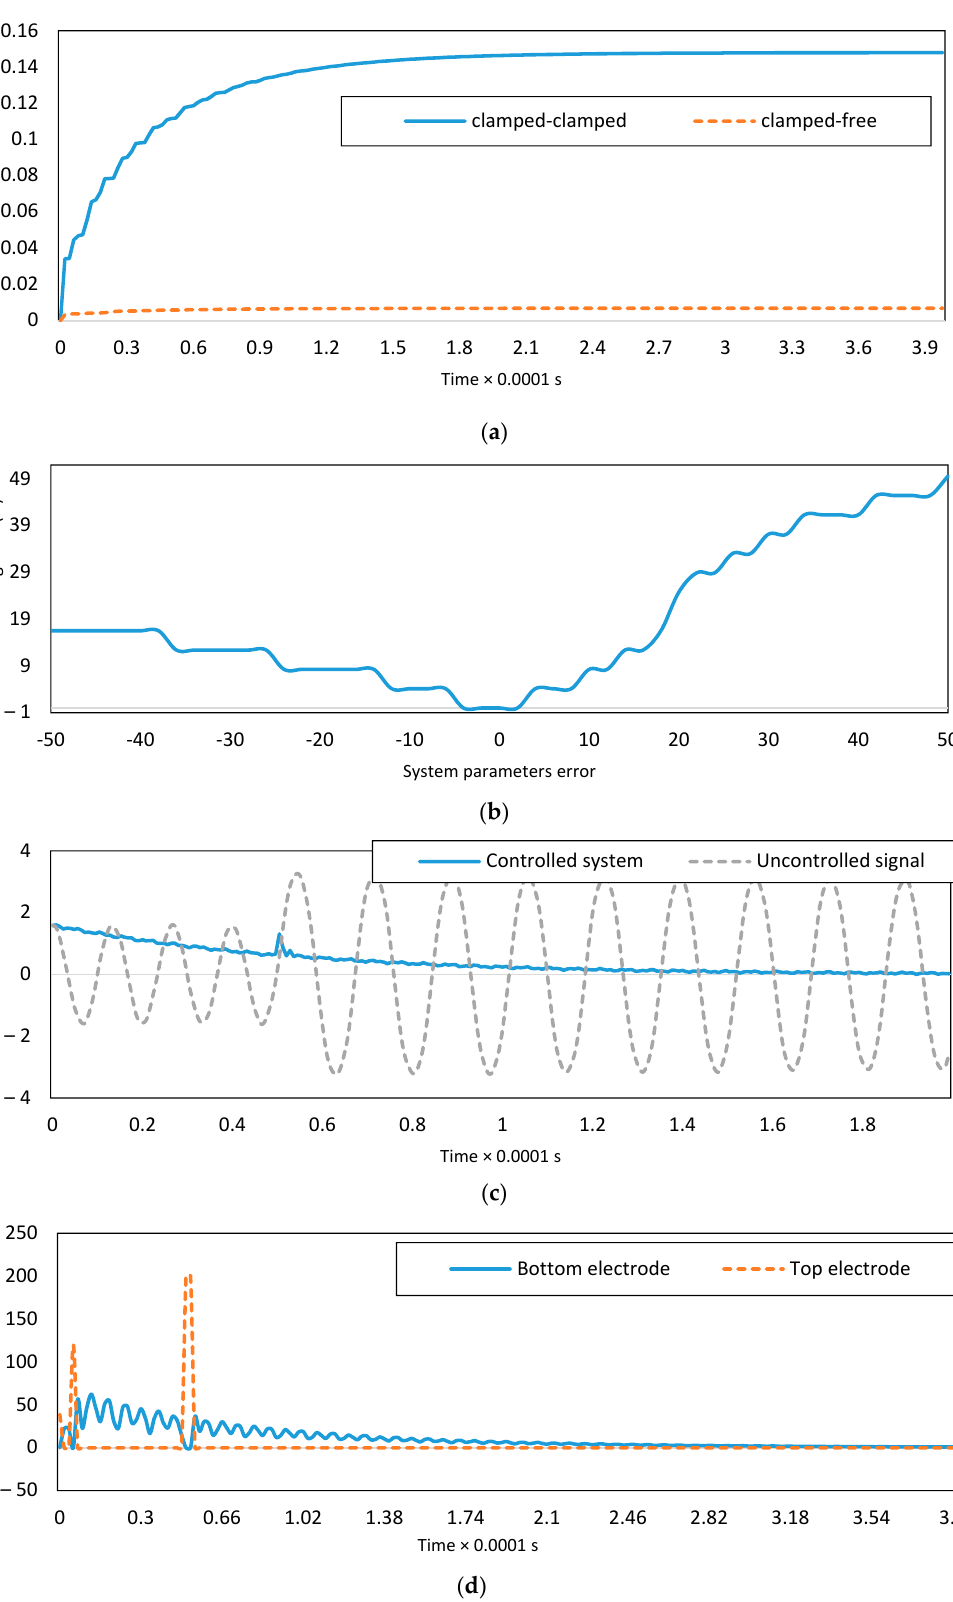
Figure 8a. The energy is defined as (cid:1516) (cid:1848) (cid:2870) (cid:1856)(cid:1872) . It can be seen that the consumption of energy is less for clamped-clamped switch, which is due to the higher structural stiffness of this micro-switch.